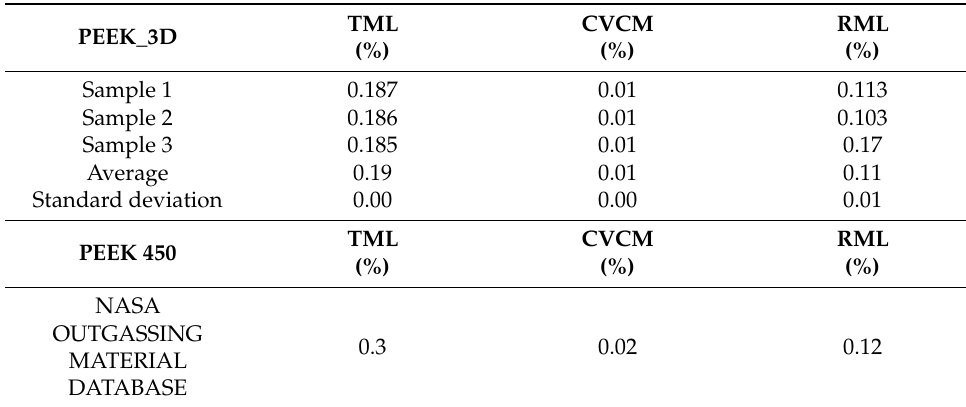
Table 9. Outgassing Test Results according to ECSS standard